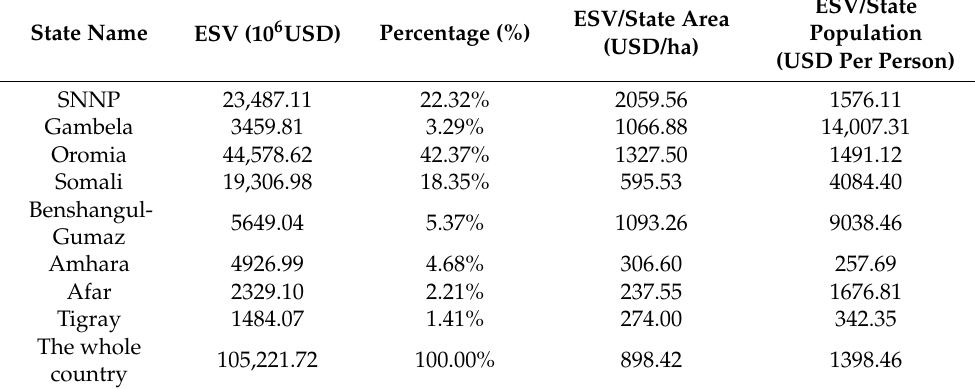
Table 5. Statistics of ecosystem service value of grassland types for different